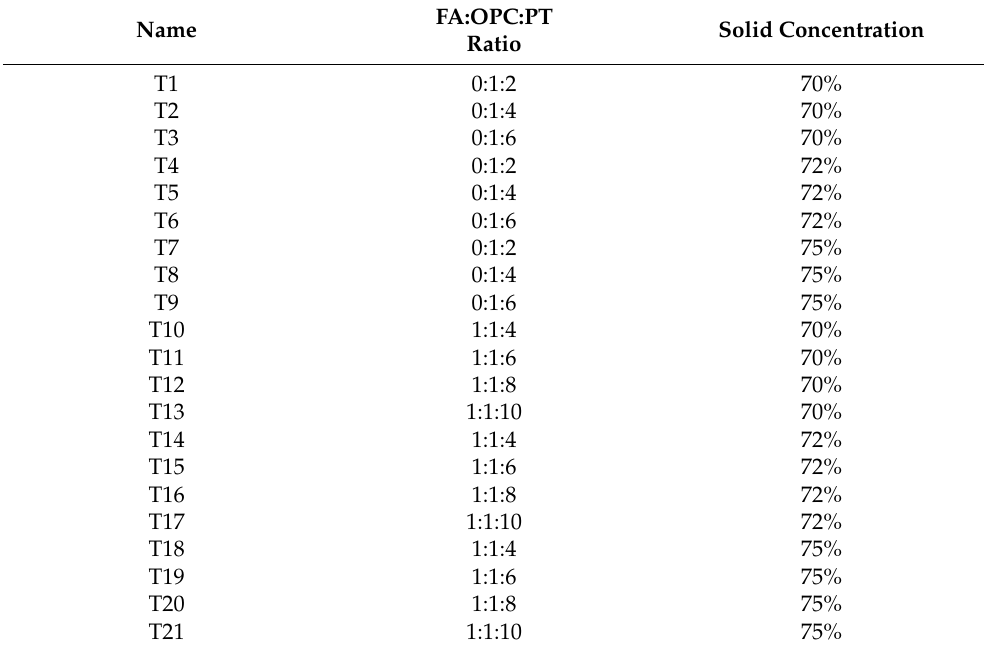
Table 2. Experimental